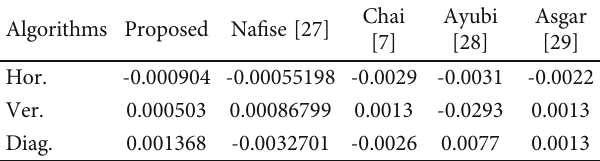
Table 3: Correlation coe ffi cient comparison of